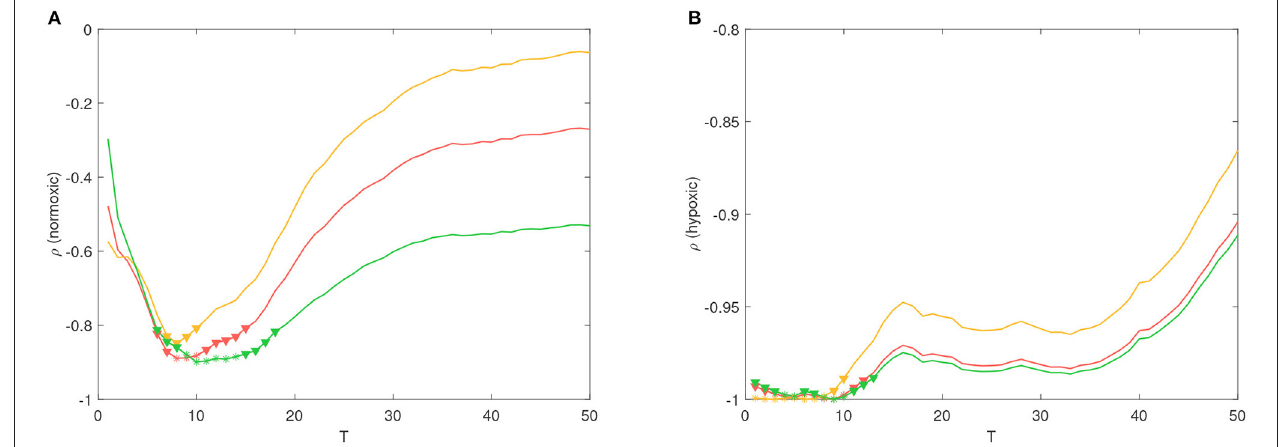
FIGURE 4 | Partial correlation coefficient ρ between τ u vs. DC (red line), τ r vs. AC (yellow line) and 1τ vs. DR (green line), for different values of T . Coefficients were computed from the (A) normoxic and (B) hypoxic fetuses. It is worth noting that the number of data points available for the computation were 7 and 5 at each T -value. ∗ ( p < 0.05) and ▽ ( p < 0.1) refer to statistically significant